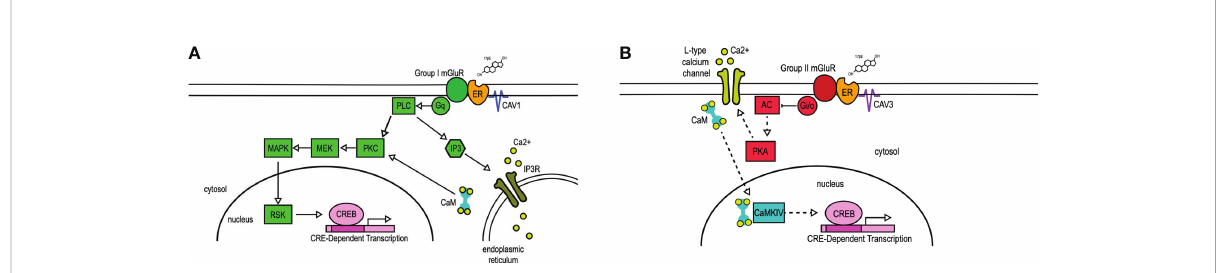
FIGURE 1 mER transactivation of group I and group II mGluRs. 17 b -Estradiol (17 b E) binds to membrane-bound estrogen receptors (ER) to activate distinct signaling pathways via Group I (A) or Group II (B) mGluRs. (A) Membrane-ER interactions with Group I mGluRs, dependent on CAV1, activates G q -mediated signaling through protein lipase C (PLC) and protein kinase C (PKC), subsequent activation of MEK, MAPK, and RSK, and ultimately the phosphorylation of CREB. PLC also activates IP3, which binds to the IP3 receptor (IP3R) to result in the release of intracellular calcium (Ca 2+ ). (B) Membrane-ER activation of Group II mGluRs, dependent on CAV3, results in the G i/o -mediated inhibition of adenylyl cyclase (AC), decreasing the activity (indicated by dashed lines) of protein kinase A (PKA). This results in reduced L-type calcium channel currents and L-type calcium channel-dependent CREB phosphorylation. CaM, Calmodulin; CaMKIV, calmodulin-dependent protein kinase IV; CAV, caveolin; IP3, inositol triphosphate; MEK, MAPK/ERK kinase; MAPK, mitogen-activated protein kinase; RSK, ribosomal S6 kinase. Figure adapted from